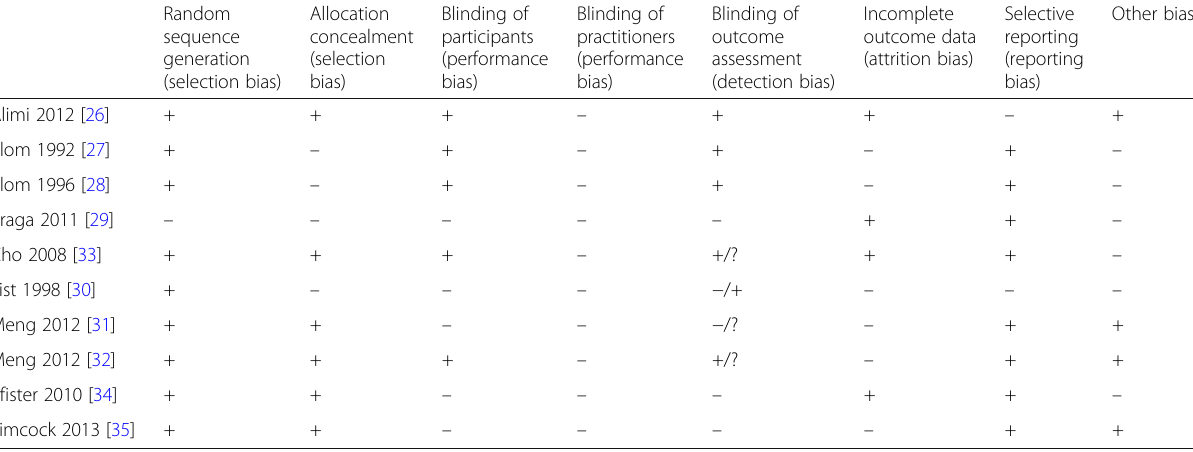
Table 3 The risk of bias in all the included studies (top-down) according to Cochrane Collaboration ’ s biases tool (from left to right). The plus sign indicating low risk of bias whereas the minus sign indicates high risk of bias. The question mark indicates an unknown risk of